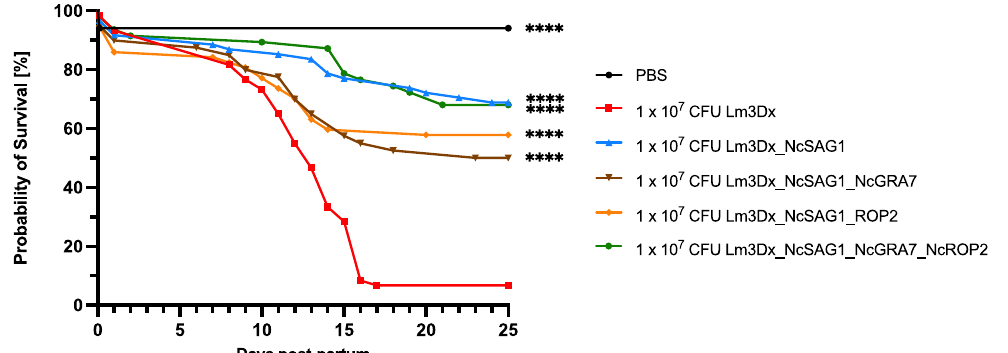
Figure 2. Survival curves of the different L. monocytogenes vaccine strains in the pregnant neosporosis mouse model. Survival rates of pups were plotted daily in Kaplan–Meier graphs and each curved was analyzed by the Log-rank (Mantel–Cox) test. Significant differences were calculated by comparing the different strains with the positive control group (**** p < 0.0001). Table 2. Compilation of the results of the vaccine study, including serological analysis, parasite load, litter size and mortality rates of non-pregnant and pregnant mice. The infection control group C+ was immunized with the empty vector Lm3Dx and was challenged as well with N. caninum tachyzoites. The animals in the negative control group C − received PBS and were inoculated with 1 × 10 5 BALB/c dermal fibroblasts. Mice were euthanized 25 days post-partum, and the cerebral parasite load of non-pregnant and pregnant animals as well as of surviving pups was quantified by RT-qPCR. Statistical analysis between animals from the different vaccine groups and the positive control group was performed by the Chi-squared (and Fisher’s exact) test with the GraphPad Prism software. p -values lower than 0.05 were considered statistically